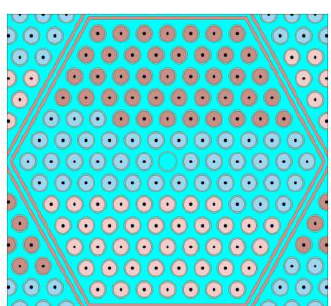
Figure 2: Material-wise decomposition for a VVER fuel